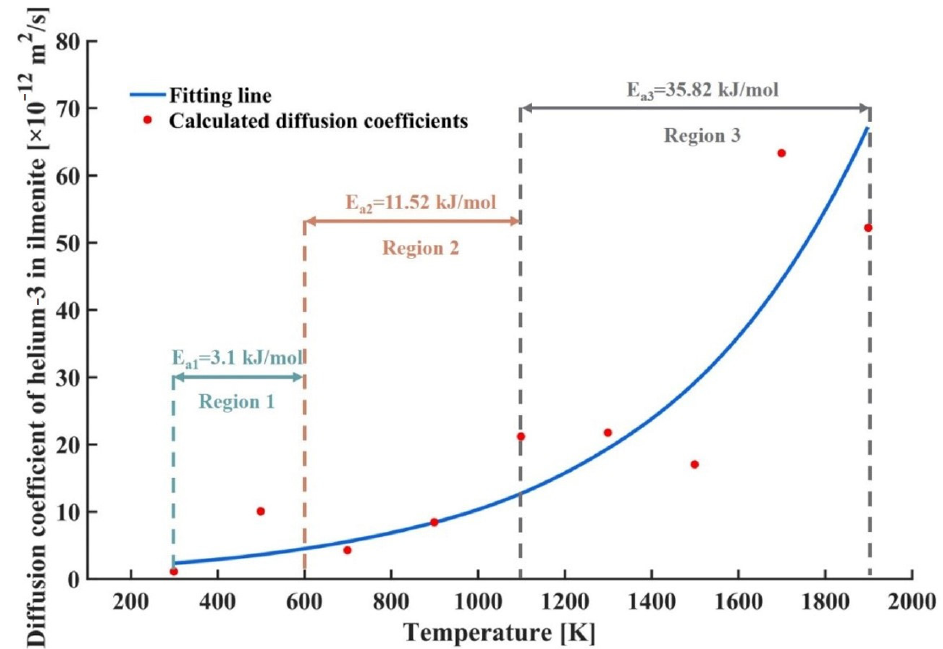
Figure 6. Variations in diffusion coefficient of helium-3 in ilmenite with